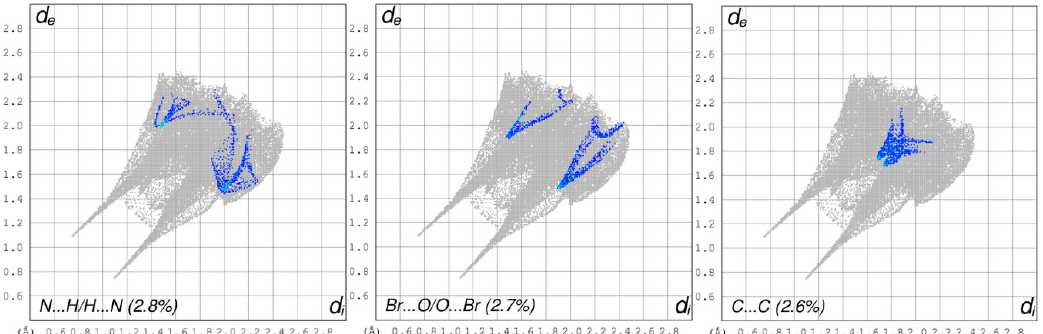
Figure 6. Decomposed two-dimensional fingerprint plots for 5Br1Mura. Various close contacts and their proportional contributions are reported. Other (not shown) intermolecular contacts contribute approximately 1% to the Hirshfeld surface mapping.